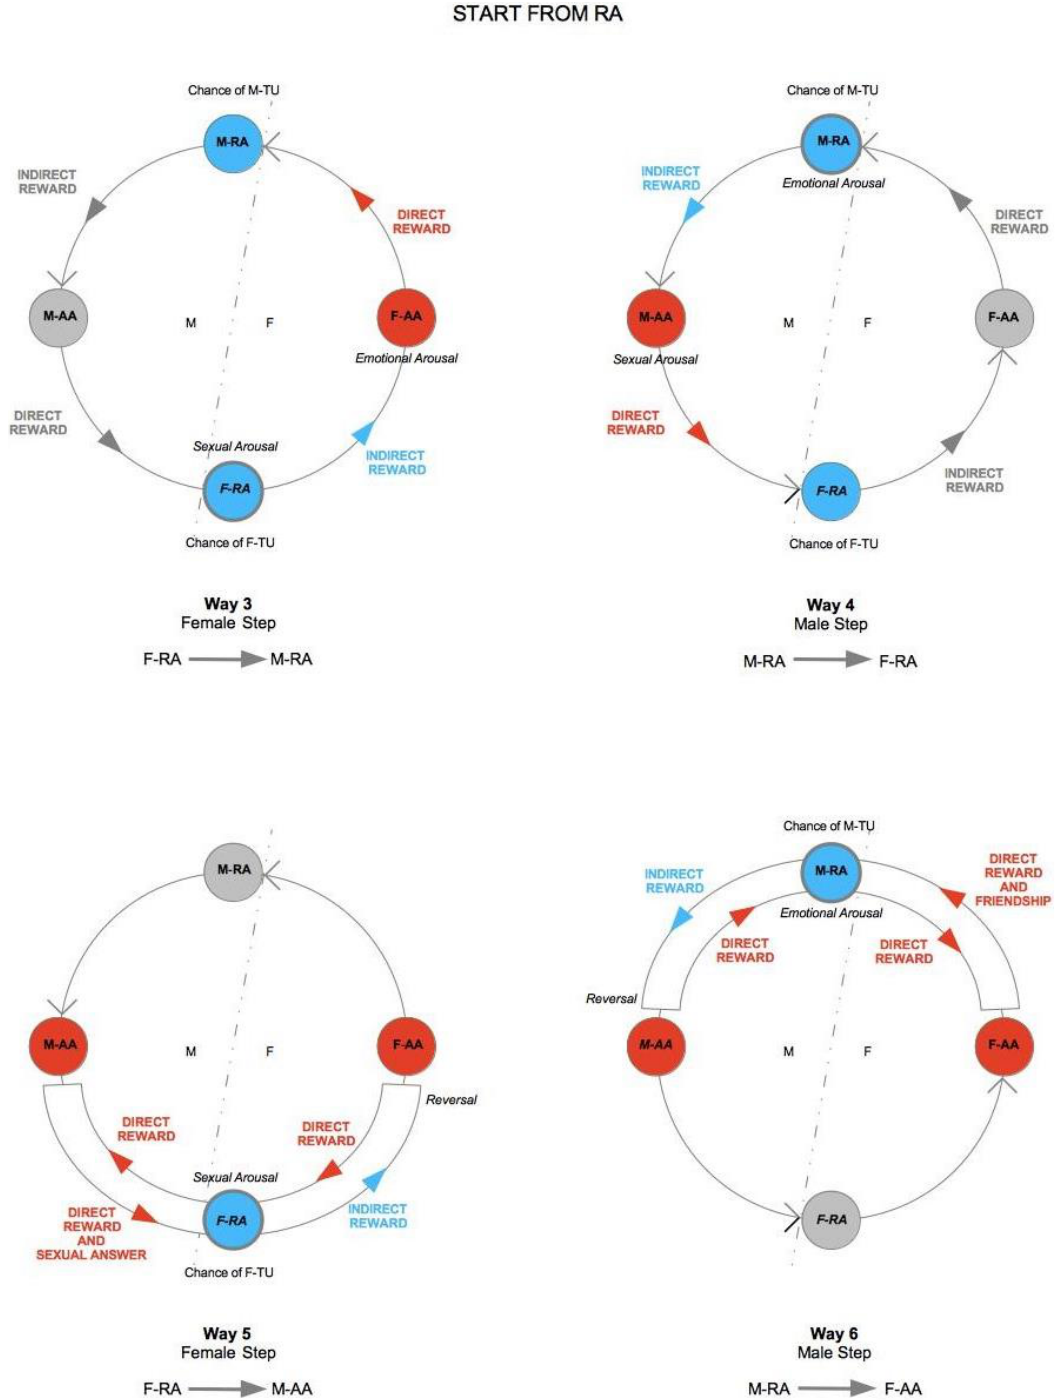
Figure 10. Ways 3–6.